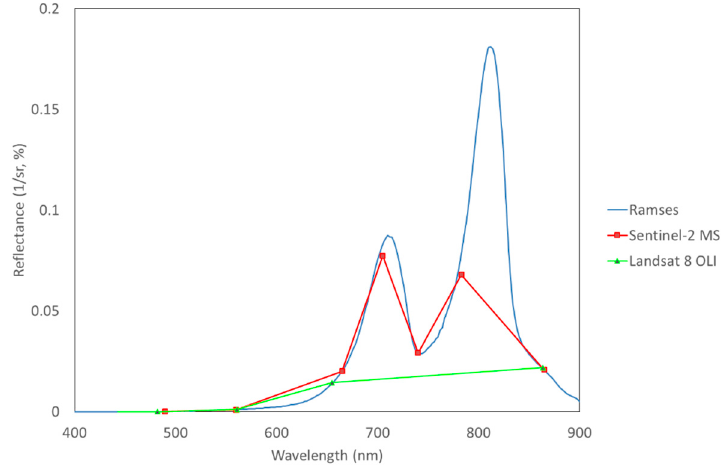
Figure 7. A glint-free reflectance spectrum of black-water Nohipalu Mustjärv measured with field radiometer Ramses (blue spectrum) and reflectance spectra calculated from the same spectrum using Sentinel-2 MSI (red) and Landsat 8 OLI (green) spectral response functions.